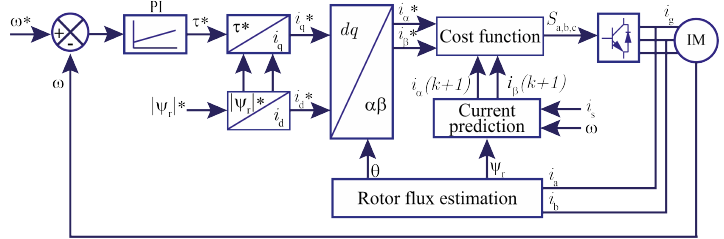
Figure 3. Block diagram of